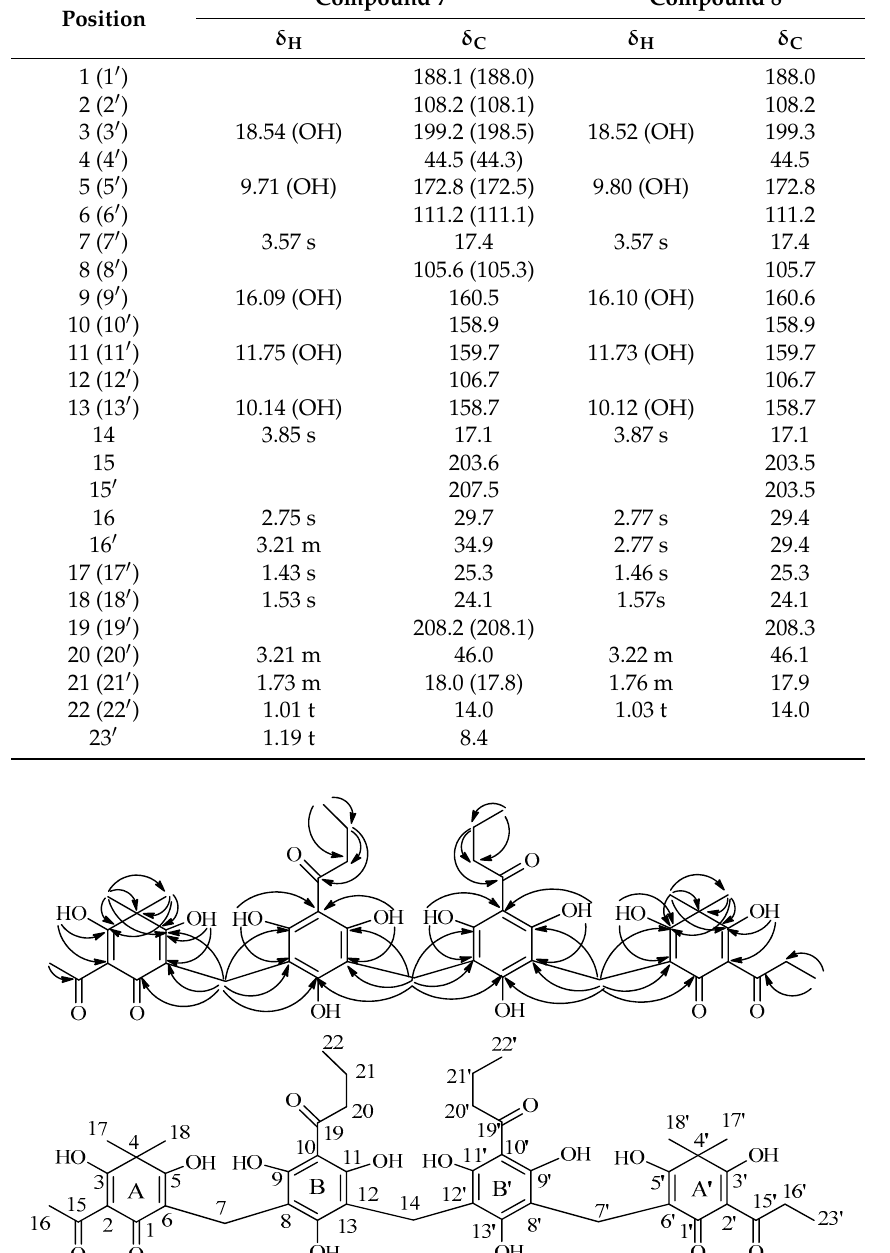
Table 2. 1 H- and 13 C-NMR spectroscopic data for compounds 7 and 8 in CDCl 3 .